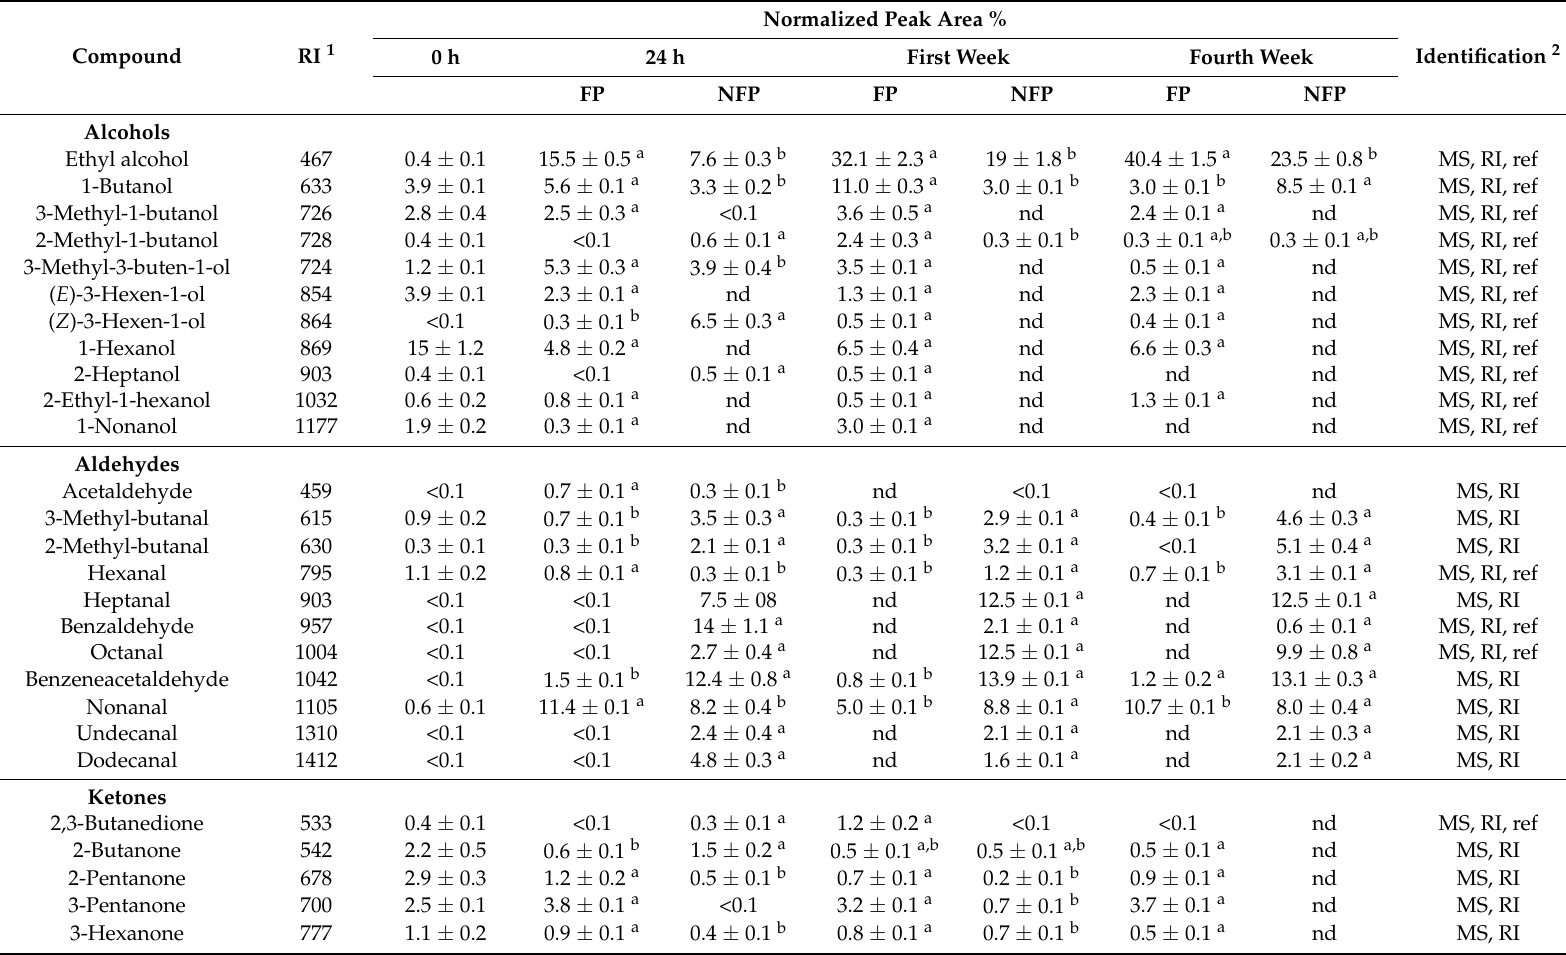
Table 1. Volatile compounds identified in the initial pomegranate beverage (NFP) and fermented pomegranate beverage (FP) by Lactobacillus paracasei K5 at 0 h and 24 h of fermentation as well at the first week and the fourth week of